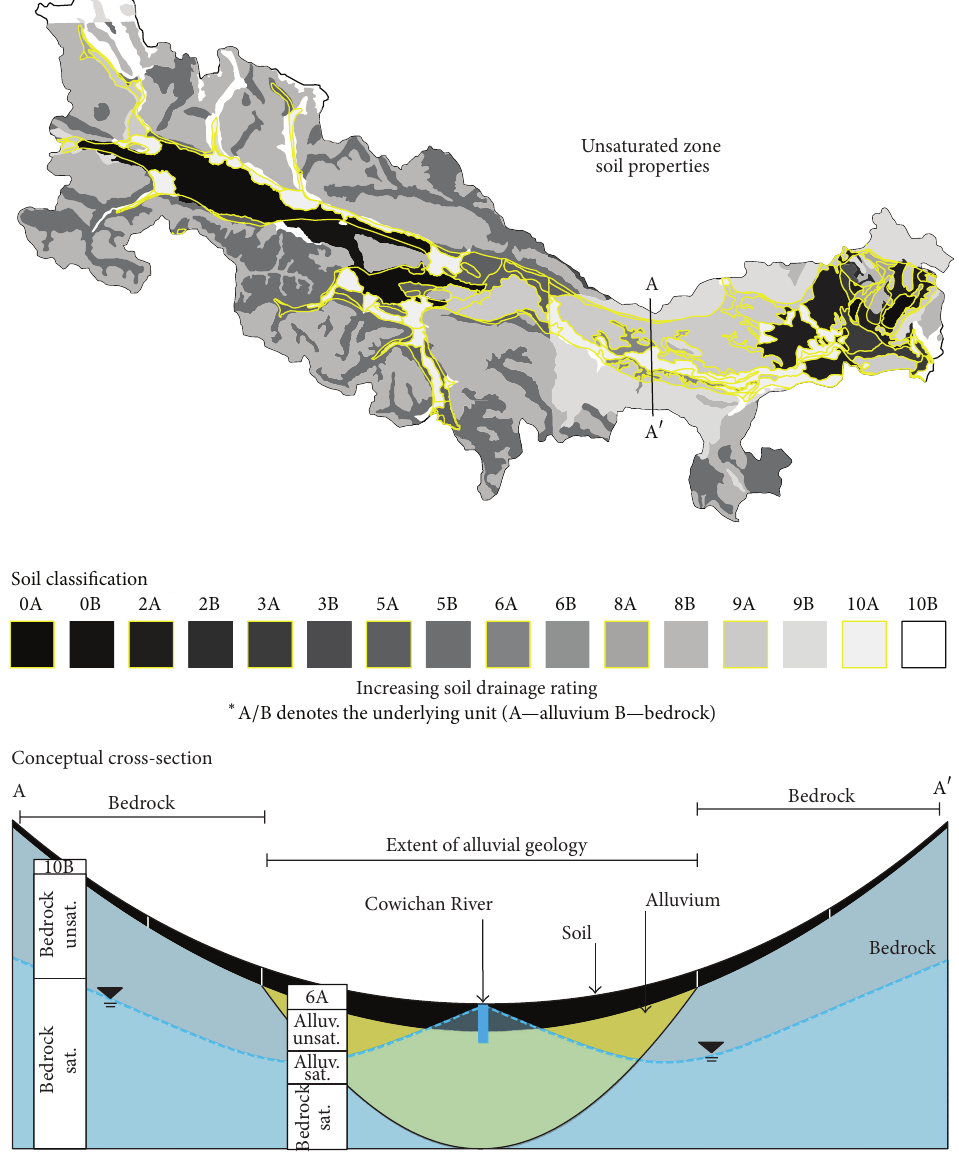
Figure 7: Conceptual representation of the variation of unsaturated zone soils within the MIKE SHE model, spatially and with depth.